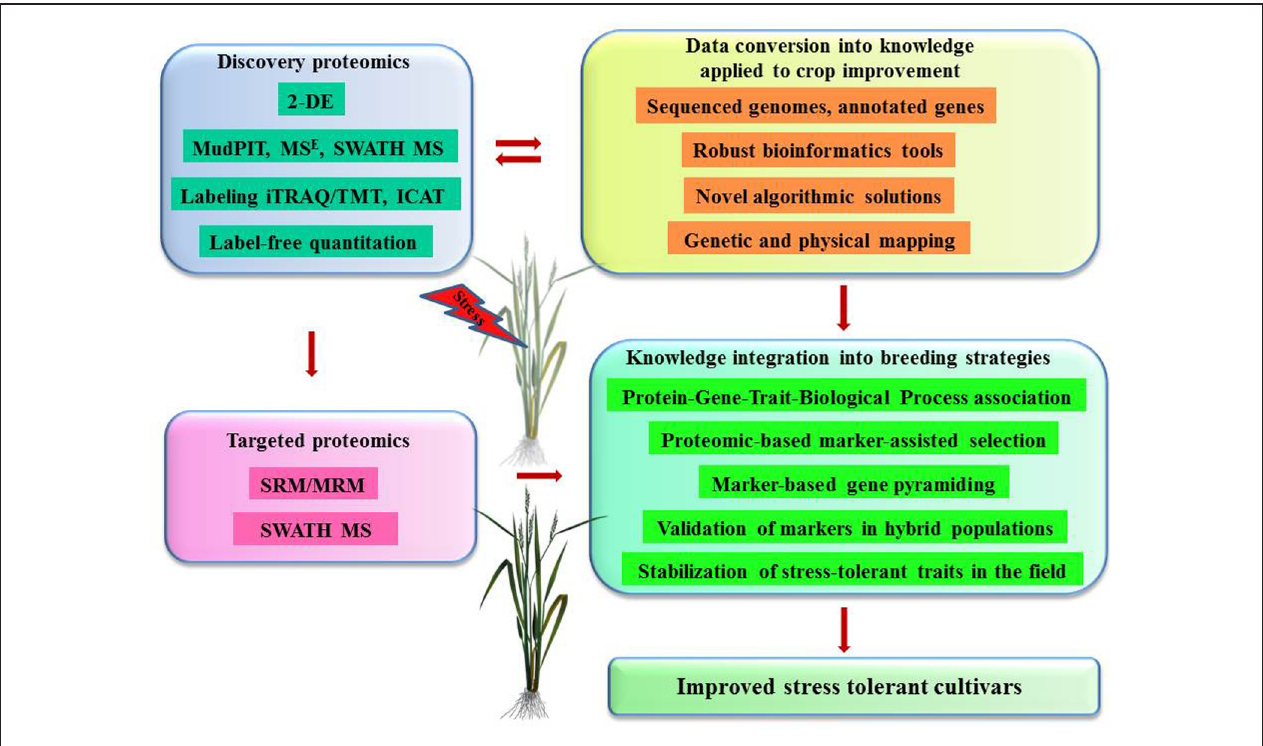
FIGURE 2 | Proteomics contribution to biotechnology of crop improvement – future challenges and prospects. Discovery-based proteomics strategies contribute with important information on candidate proteins, biological processes, and mechanisms controlling tolerance to abiotic stresses. This information is further converted into